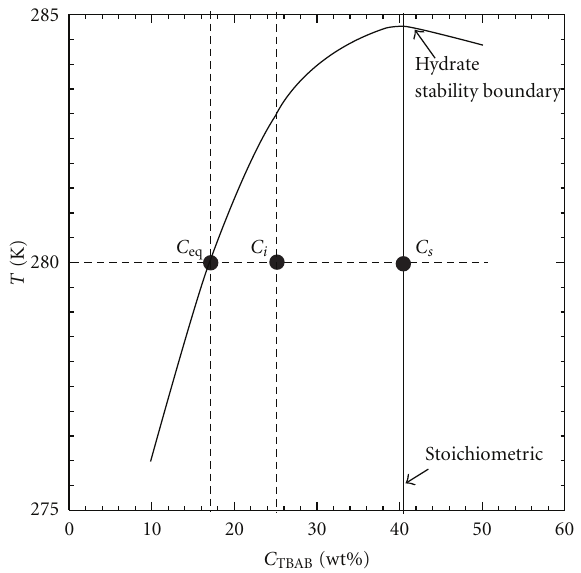
Figure 2: Temperature composition diagram for the TBAB + water mixed system containing stability boundary of Type A (tetragonal) hydrate [3, 10].